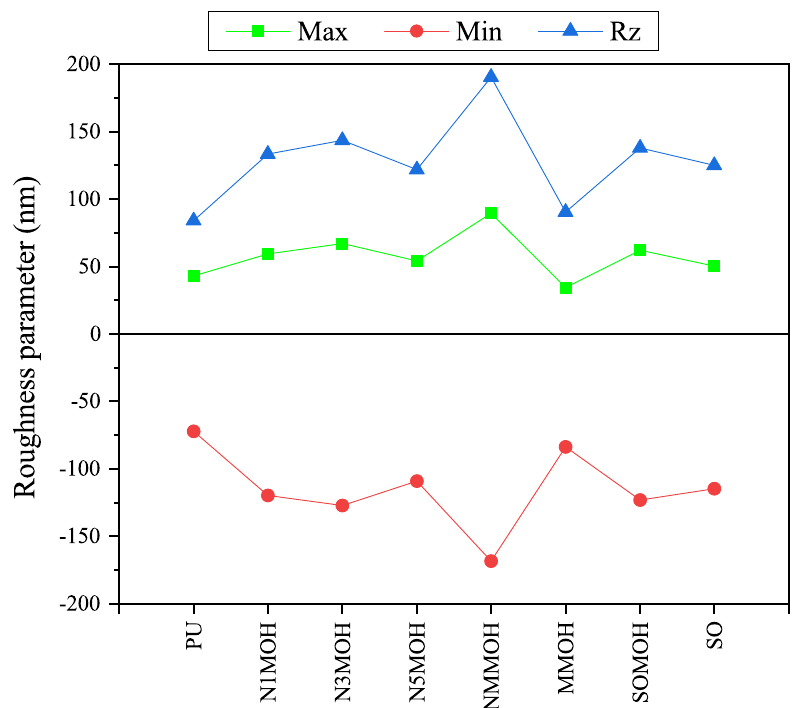
Figure 8. Comparison of surface roughness and Rz parameters for the nano-, micro-, and hybrid composites. This graph confirms the results obtained from the contact angle and hydrophobicity